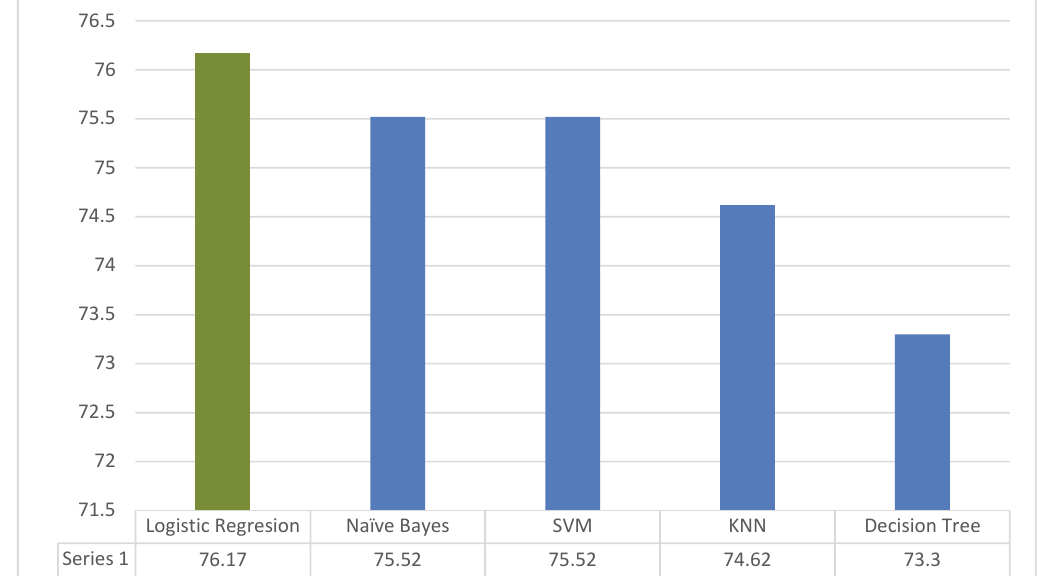
Fig. 1. The summary of the results of Accuracy for different